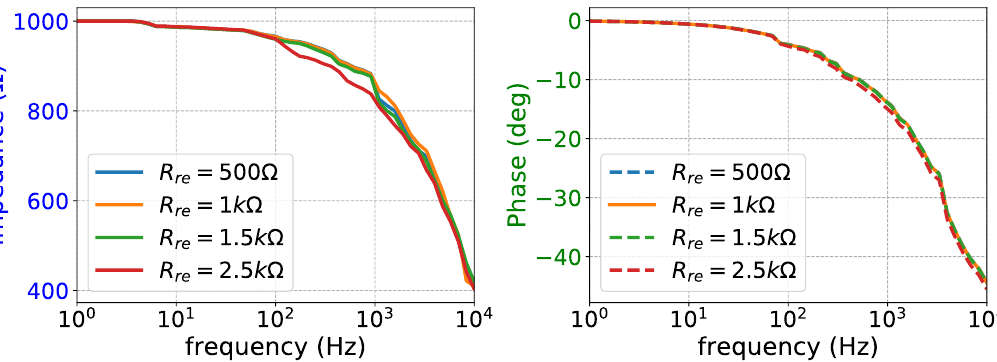
Figure 32. AC magnitude ( left ) and phase ( right ) impedance measurements for deviated shunt impedance of the positive voltage electrode (IFLF design).